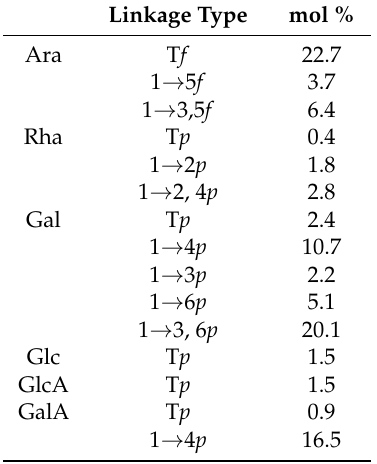
Table 2. The glycosidic linkage (mol %) present in the fraction SJZDP-II-I isolated from